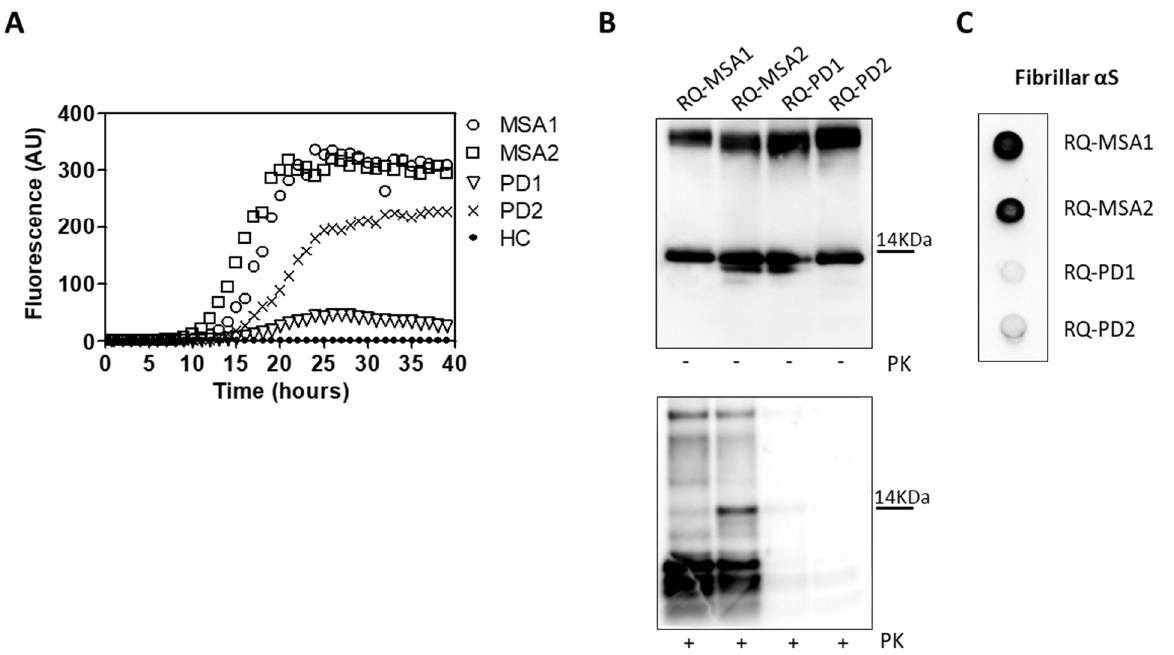
Figure 1. ( A ) α Syn_RT-QuIC analysis of OM-MSA and OM-PD samples. OM-MSA1, OM-MSA2, OM-PD1 and OM-PD2 induced a seeding activity while OM-HC did not. Curves represented in the graph were obtained by plotting the average fluorescence intensities of each sample against time. ( B ) Western blot analysis of untreated or PK digested α Syn_RT-QuIC products, collected at 40 h. RQ-MSA1, RQ-MSA2, RQ-PD1 and RQ-PD2 showed similar signal intensities before digestion. RQ-MSA1 and RQ-MSA2 were more resistant to PK digestion than RQ-PD1 and RQ-PD2. Blots were immunostained with the AS08 358 antibody. Number on the right indicates the molecular weight. ( C ) Dot blot analysis of α Syn_RT-QuIC products, collected at 40 h. Using the α Syn filament-specific MJFR antibody, RQ-MSA1 and RQ-MSA2 showed a more intense signal than RQ-PD1 and RQ-PD2. 3.2. Inflammatory Profile of Neuronal-like SH-SY5Y Cells Exposed to α Syn_RT-QuIC